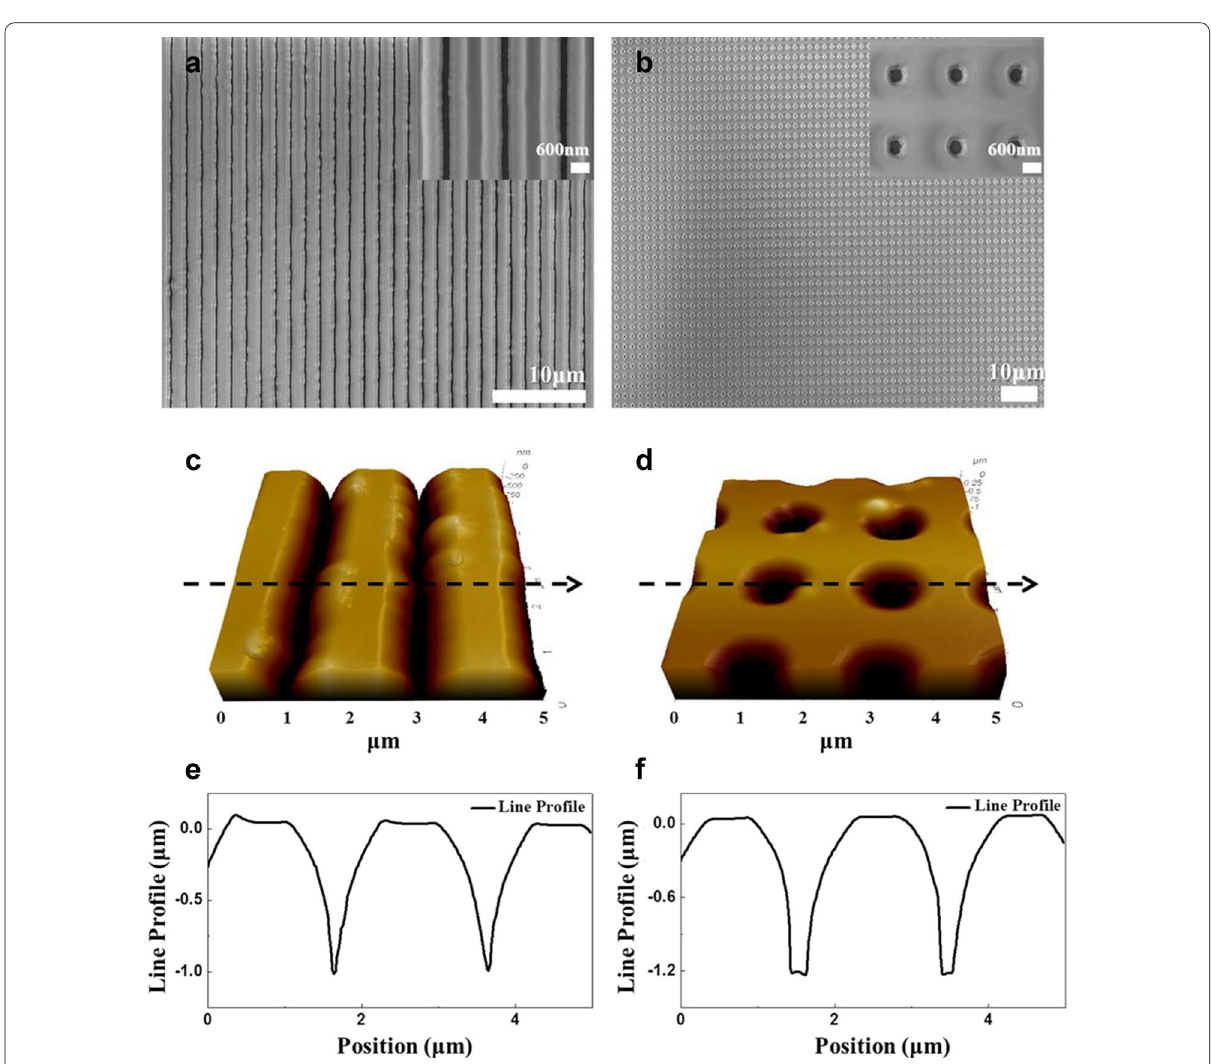
Fig. 7 FE-SEM images of large-area of a nanotrench and b nanowell array and AFM images of c nanotrench and d nanowell arrays after the DODE lithography process; the inset shows high-magnification images of nanopatterns; and line profiles of each e nanotrench and f nanowell patterns measured from AFM images; high aspect ratios greater than 20:1 were obtained